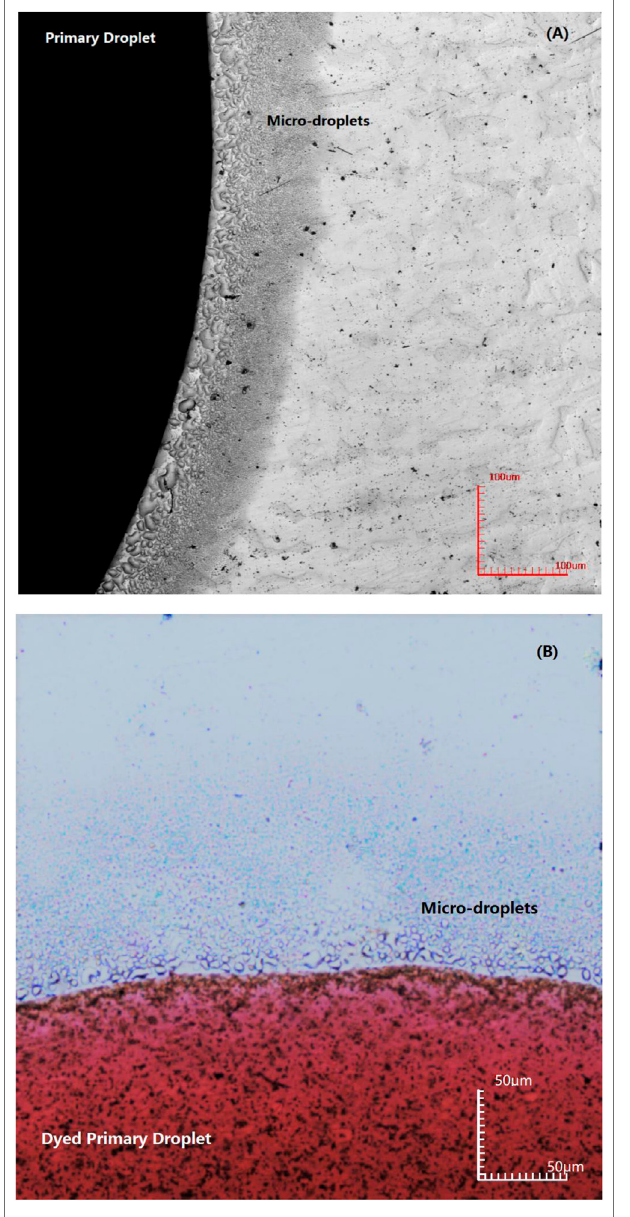
FIGURE 2 | Image of initial microdroplets formed on an iron-plated layer byconfocallaserscanningmicroscopefordifferentprimarydroplets: (A) 3.5% NaCl droplet and (B) dyed 3.5% NaCl